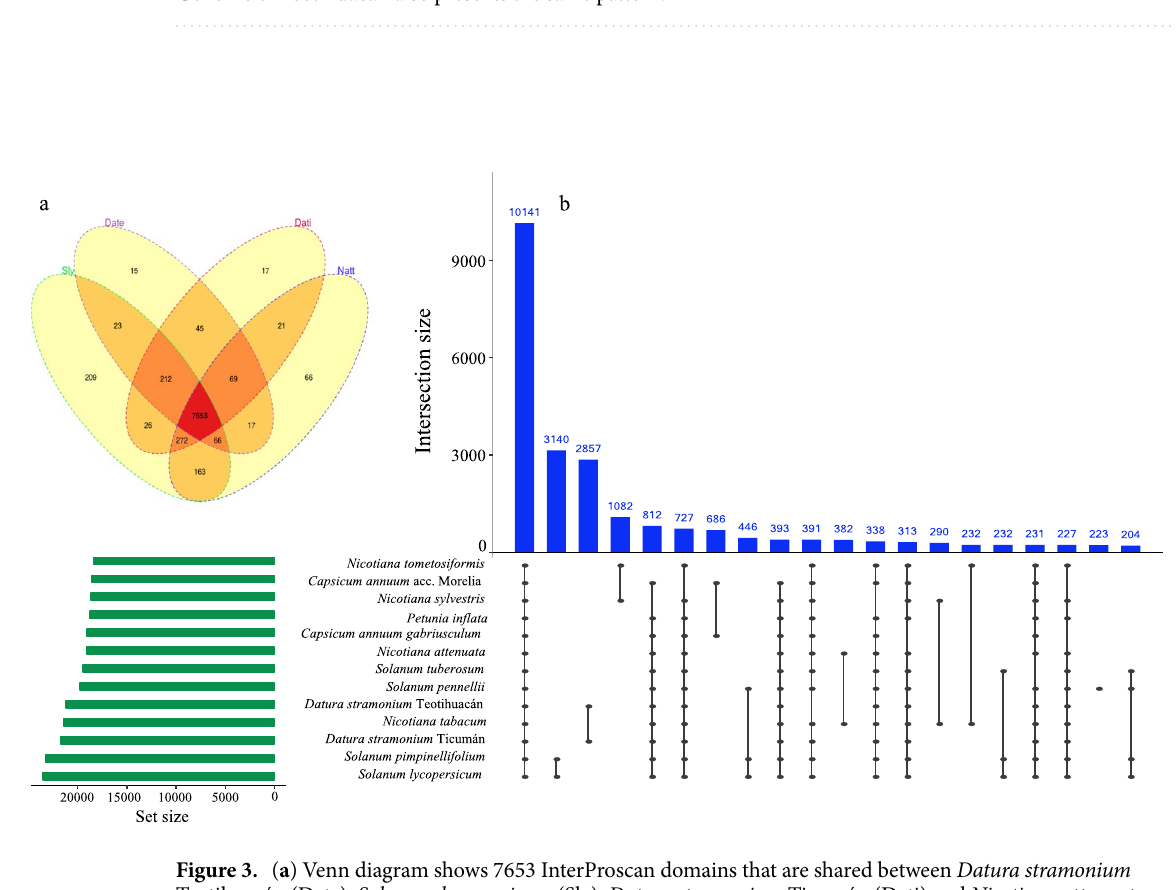
Figure 2. The repeat landscapes depict the relative abundance of repeat classes in the genome of Datura stramonium (Ticumán example) versus the Kimura divergence from the consensus. LTR/ Gypsy family is the most represented repetitive element in the genome of D. stramonium (61.33%) followed by LTR Copia family. Genome of Teotihuacán also presents the same pattern.